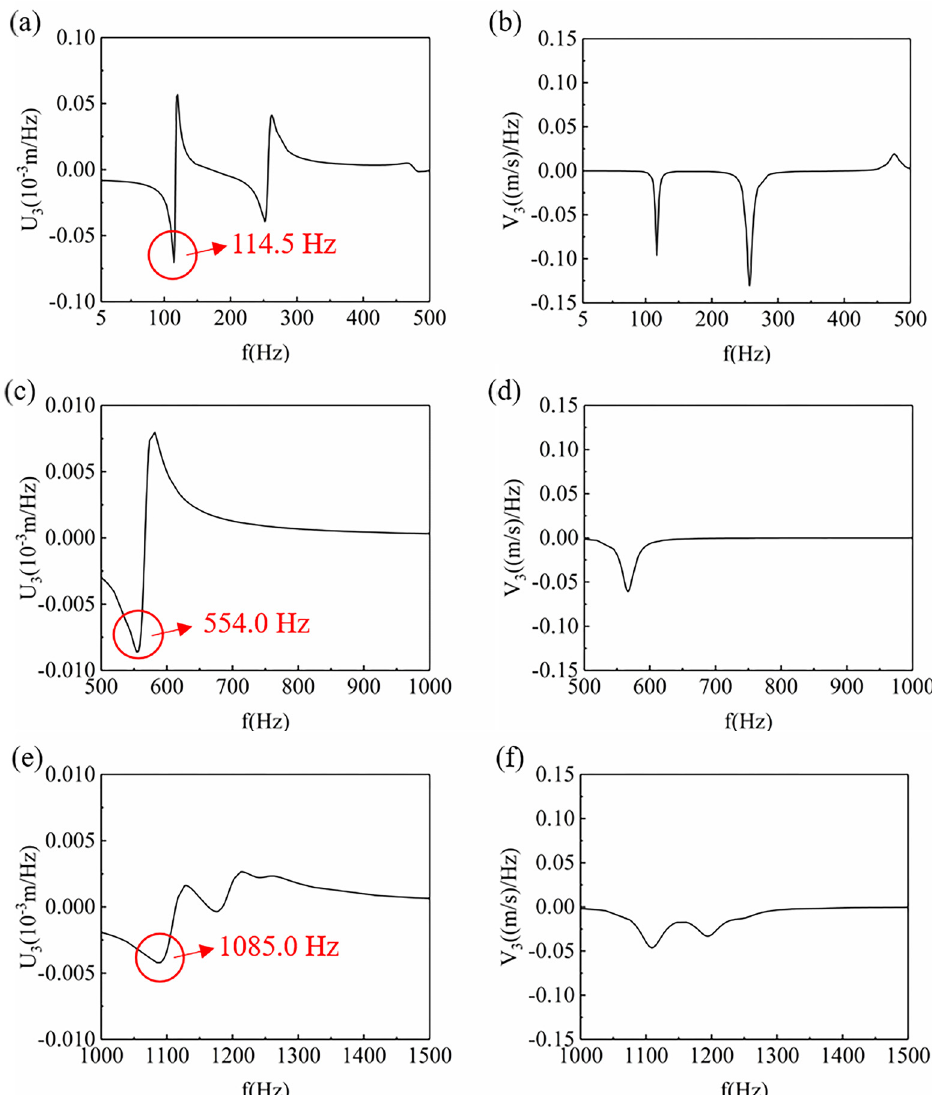
Figure 9. The displacement ( a , c , e ) and velocity ( b , d , f ) curves of the z-axis at point A of the finite element model within three frequency ranges, ( a , b ) 5–500 Hz, ( c , d ) 500–1000 Hz, ( e , f ) 1000–1500 Hz.